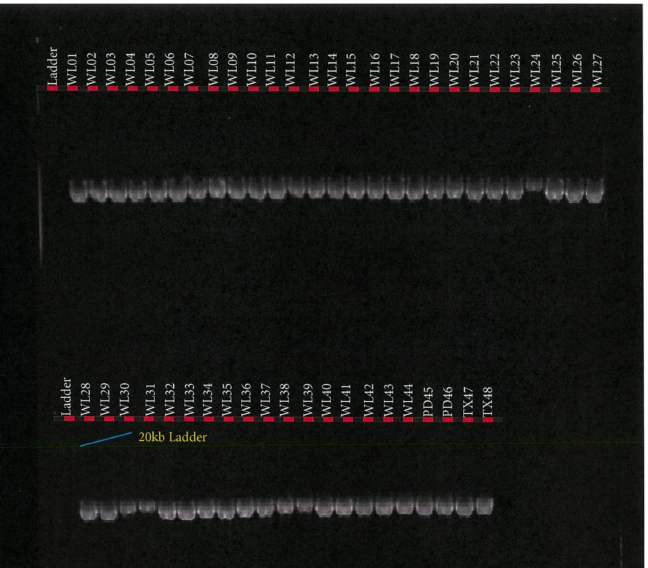
Figure 6. FABP4 PCR product of Tattykeel Australian White (WL), Poll Dorset (PD), and Texel (TX)